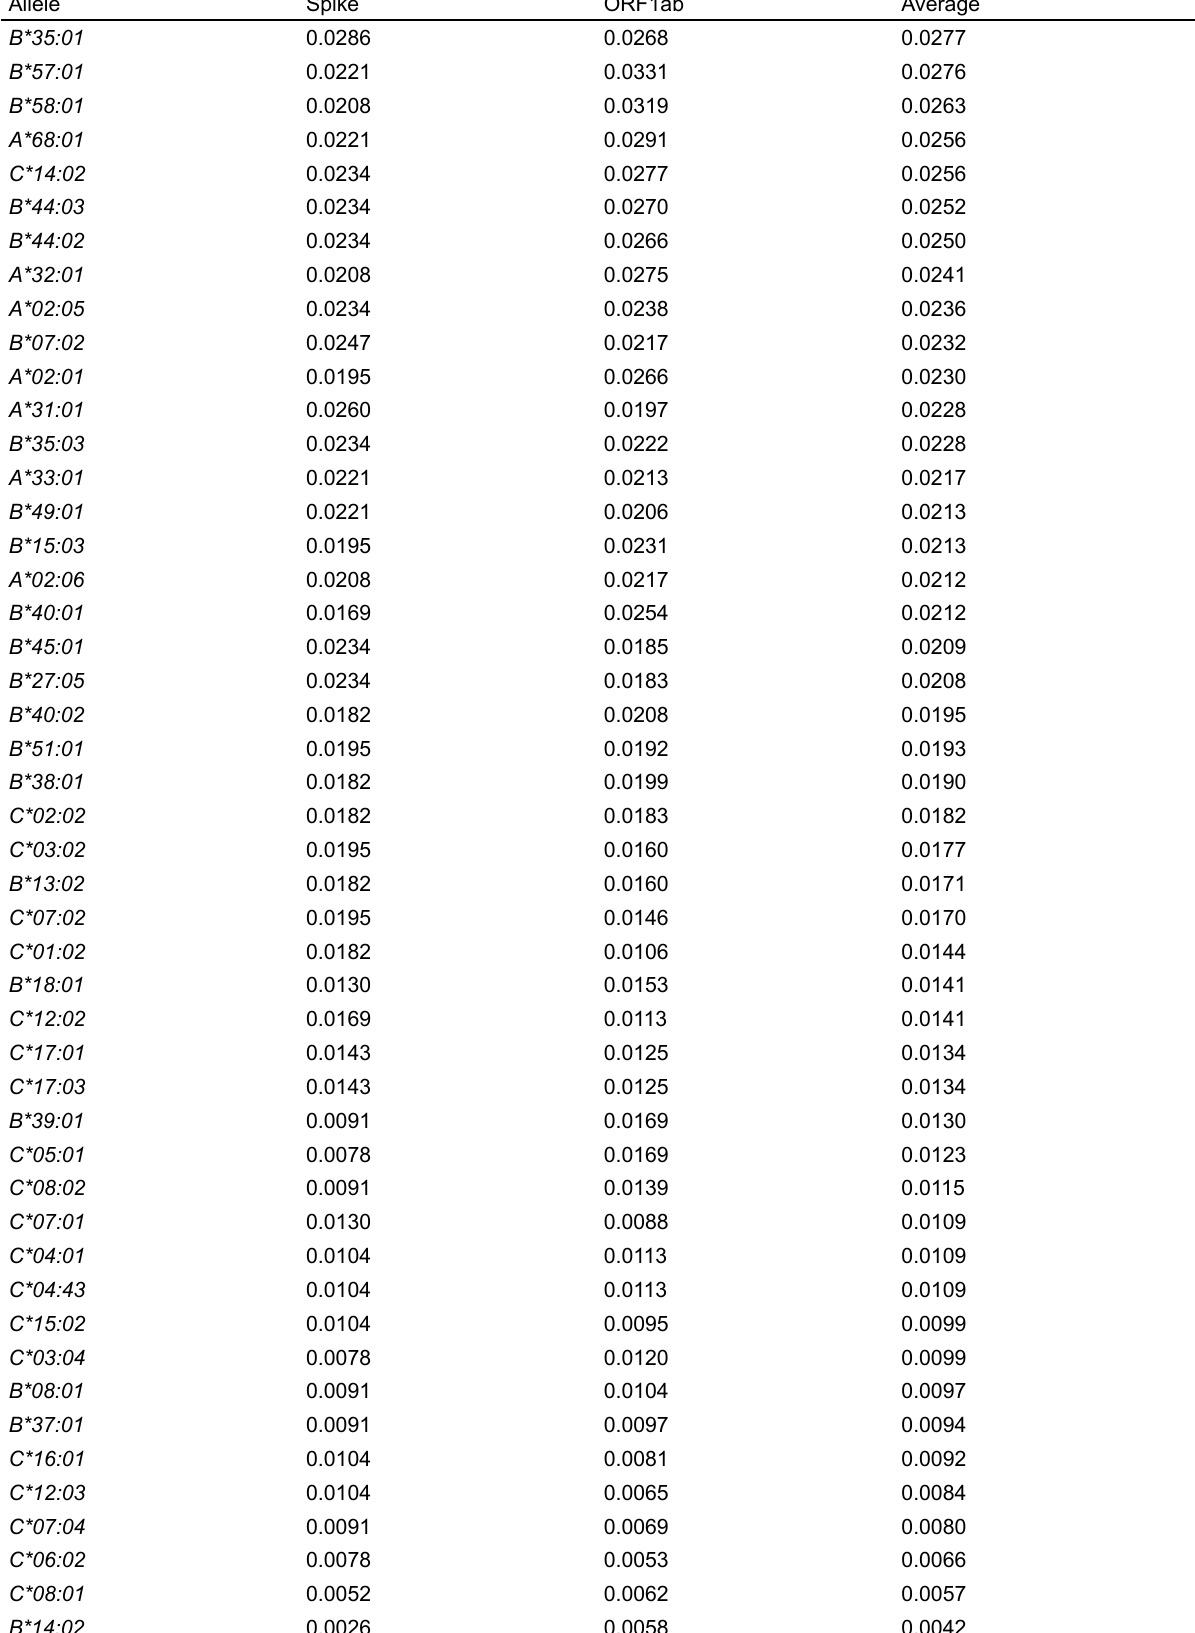
Table 2. Percentages of LPR < 1 (across all epitopes of a protein) for all alleles studied, ranked from highest to lowest ( continued